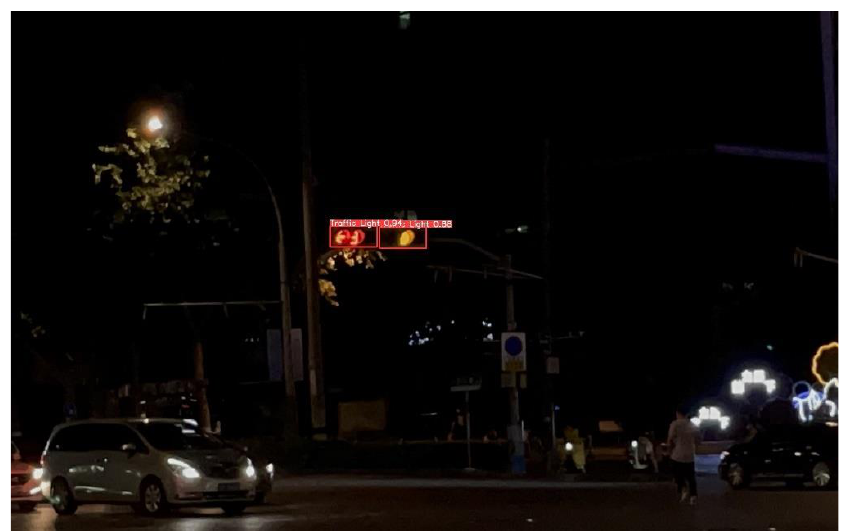
Figure 6. YOLOv5s detection night image output results.